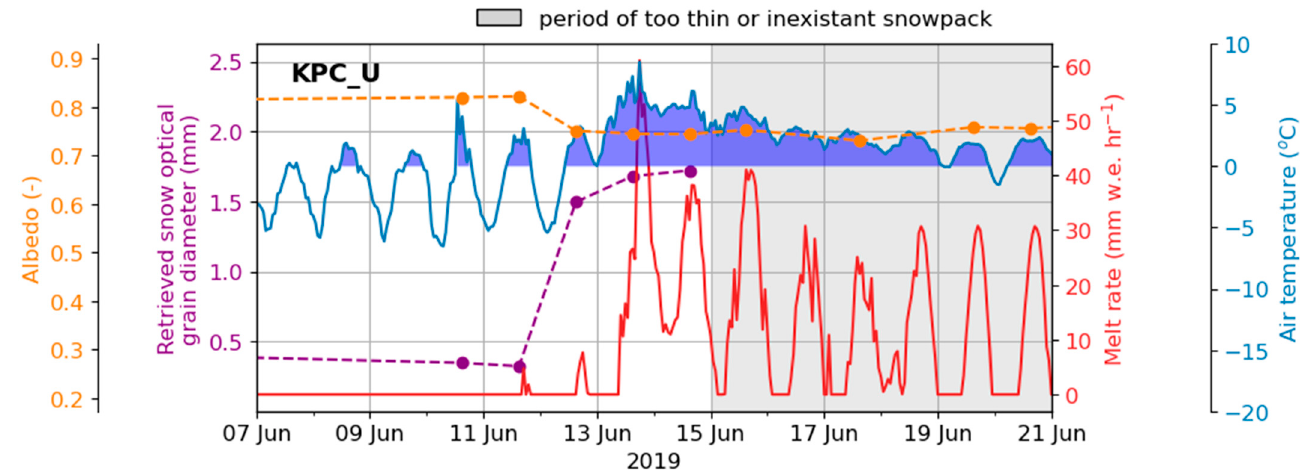
Figure 7. Retrieved snow grain optical diameter, plane broadband albedo, melt and air temperature at KPC_U AWS during the Northeast Greenland heat wave of June 2019.